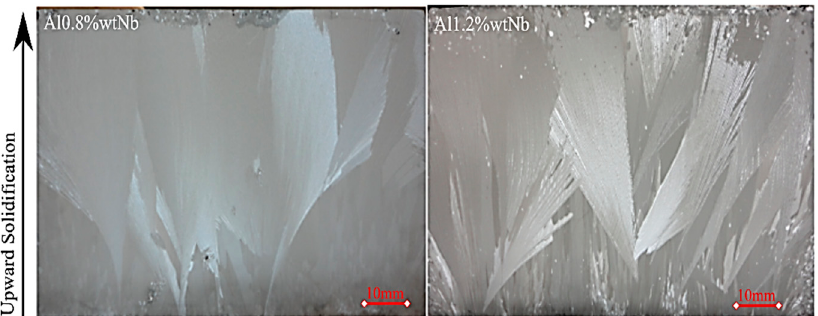
Figure 6. Typical directionally solidified macrostructures for alloys Al–0.8 Nb and Al–1.2 Nb (wt.%).